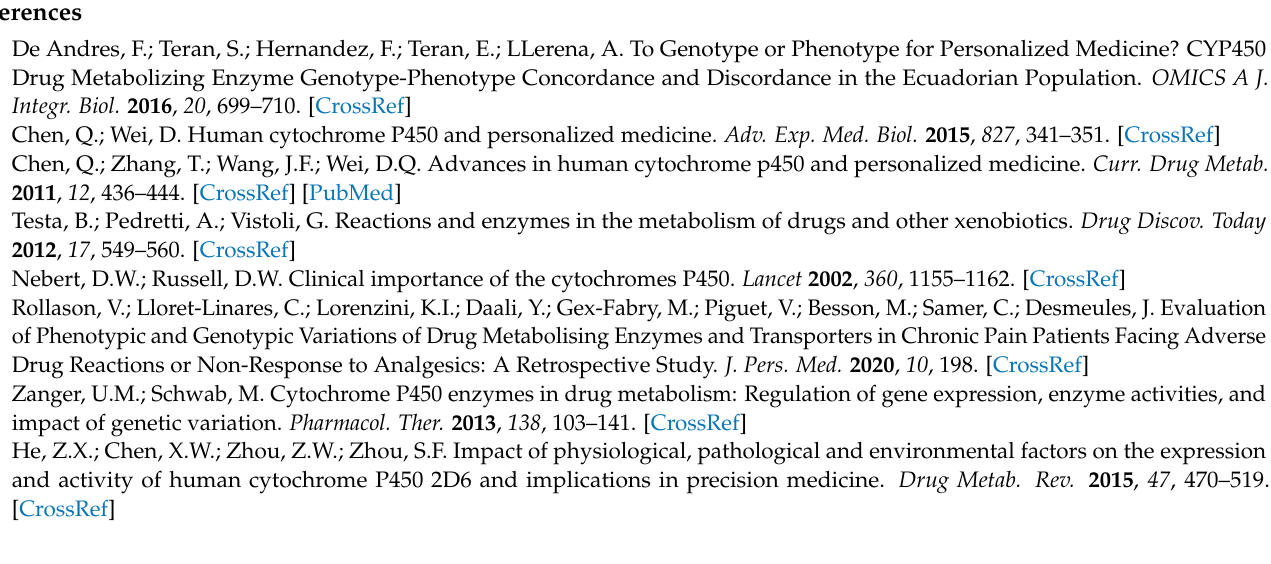
Table S2: Important variant and allele frequencies of the human CYP2B6 gene, Table S3: Important variant and allele frequencies of the human CYP2C8 gene, Table S4: Important variant and allele frequencies of the human CYP2C9 gene, Table S5: Important variant and allele frequencies of the human CYP2C19 gene, Table S6: Important variant and allele frequencies of the human CYP2D6 gene, Table S7: Important variant and allele frequencies of the human CYP2E1 gene, Table S8: Important variant and allele frequencies of the human CYP3A4 gene, Table S9: Important variant and allele frequencies of the human CYP3A5